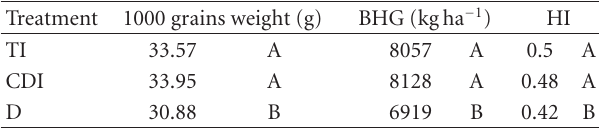
Table 3: Incidence (%) of tan spot (DTR) for total irrigation (TI), irrigation with controlled deficit (CDI), and dry (D) treatments at di ff erent sampling dates in 2009.